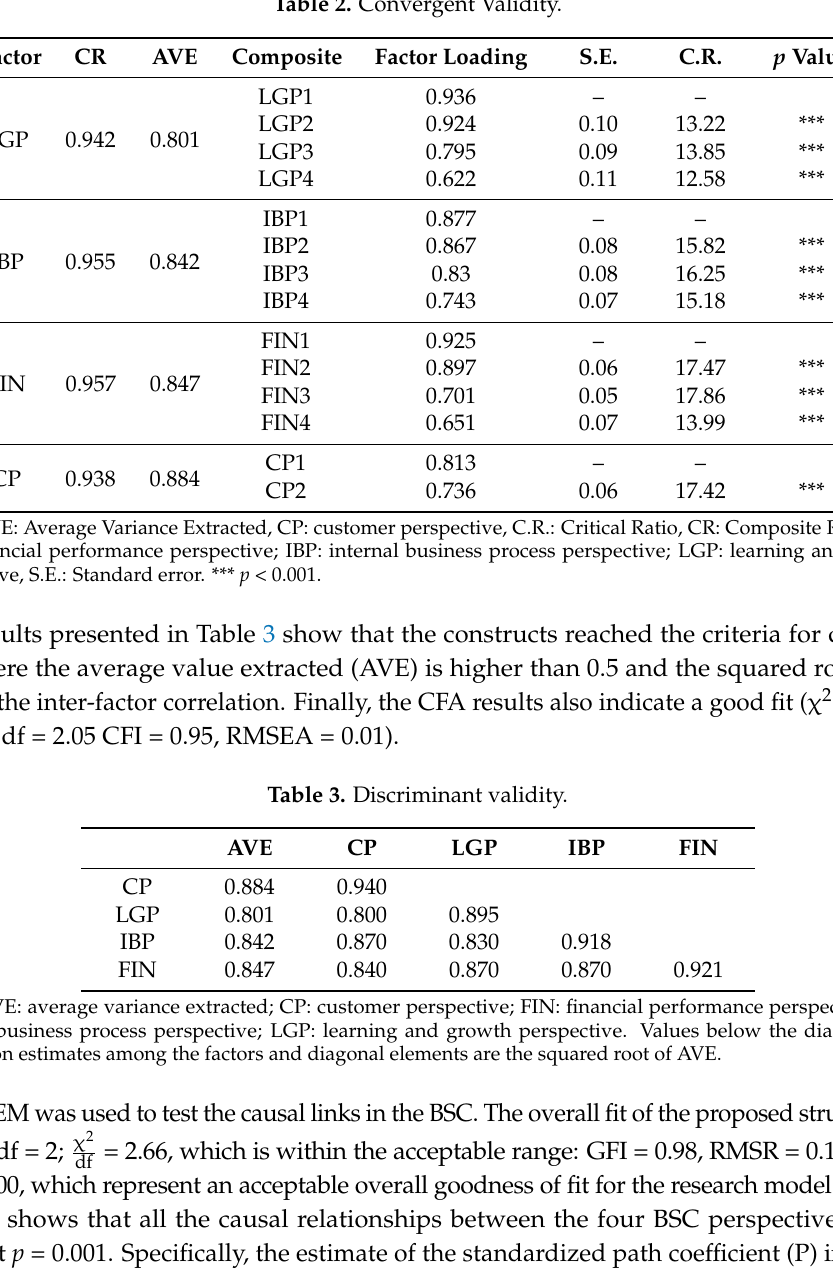
Table 2. Convergent Validity.